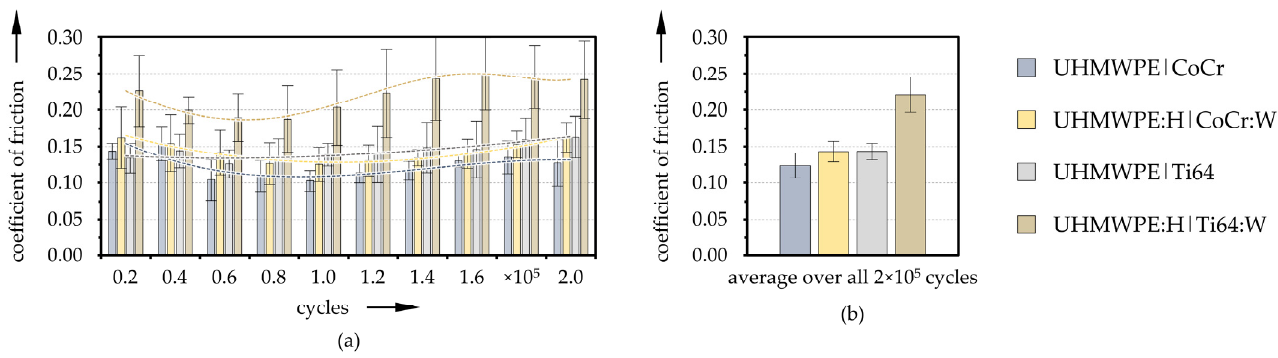
Figure 6. Evolution of the mean friction coefficients for each testing interval and trend lines ( a ) as well as averaged values over the entire test duration ( b ) for the reference and coated pairings ( n = 3).